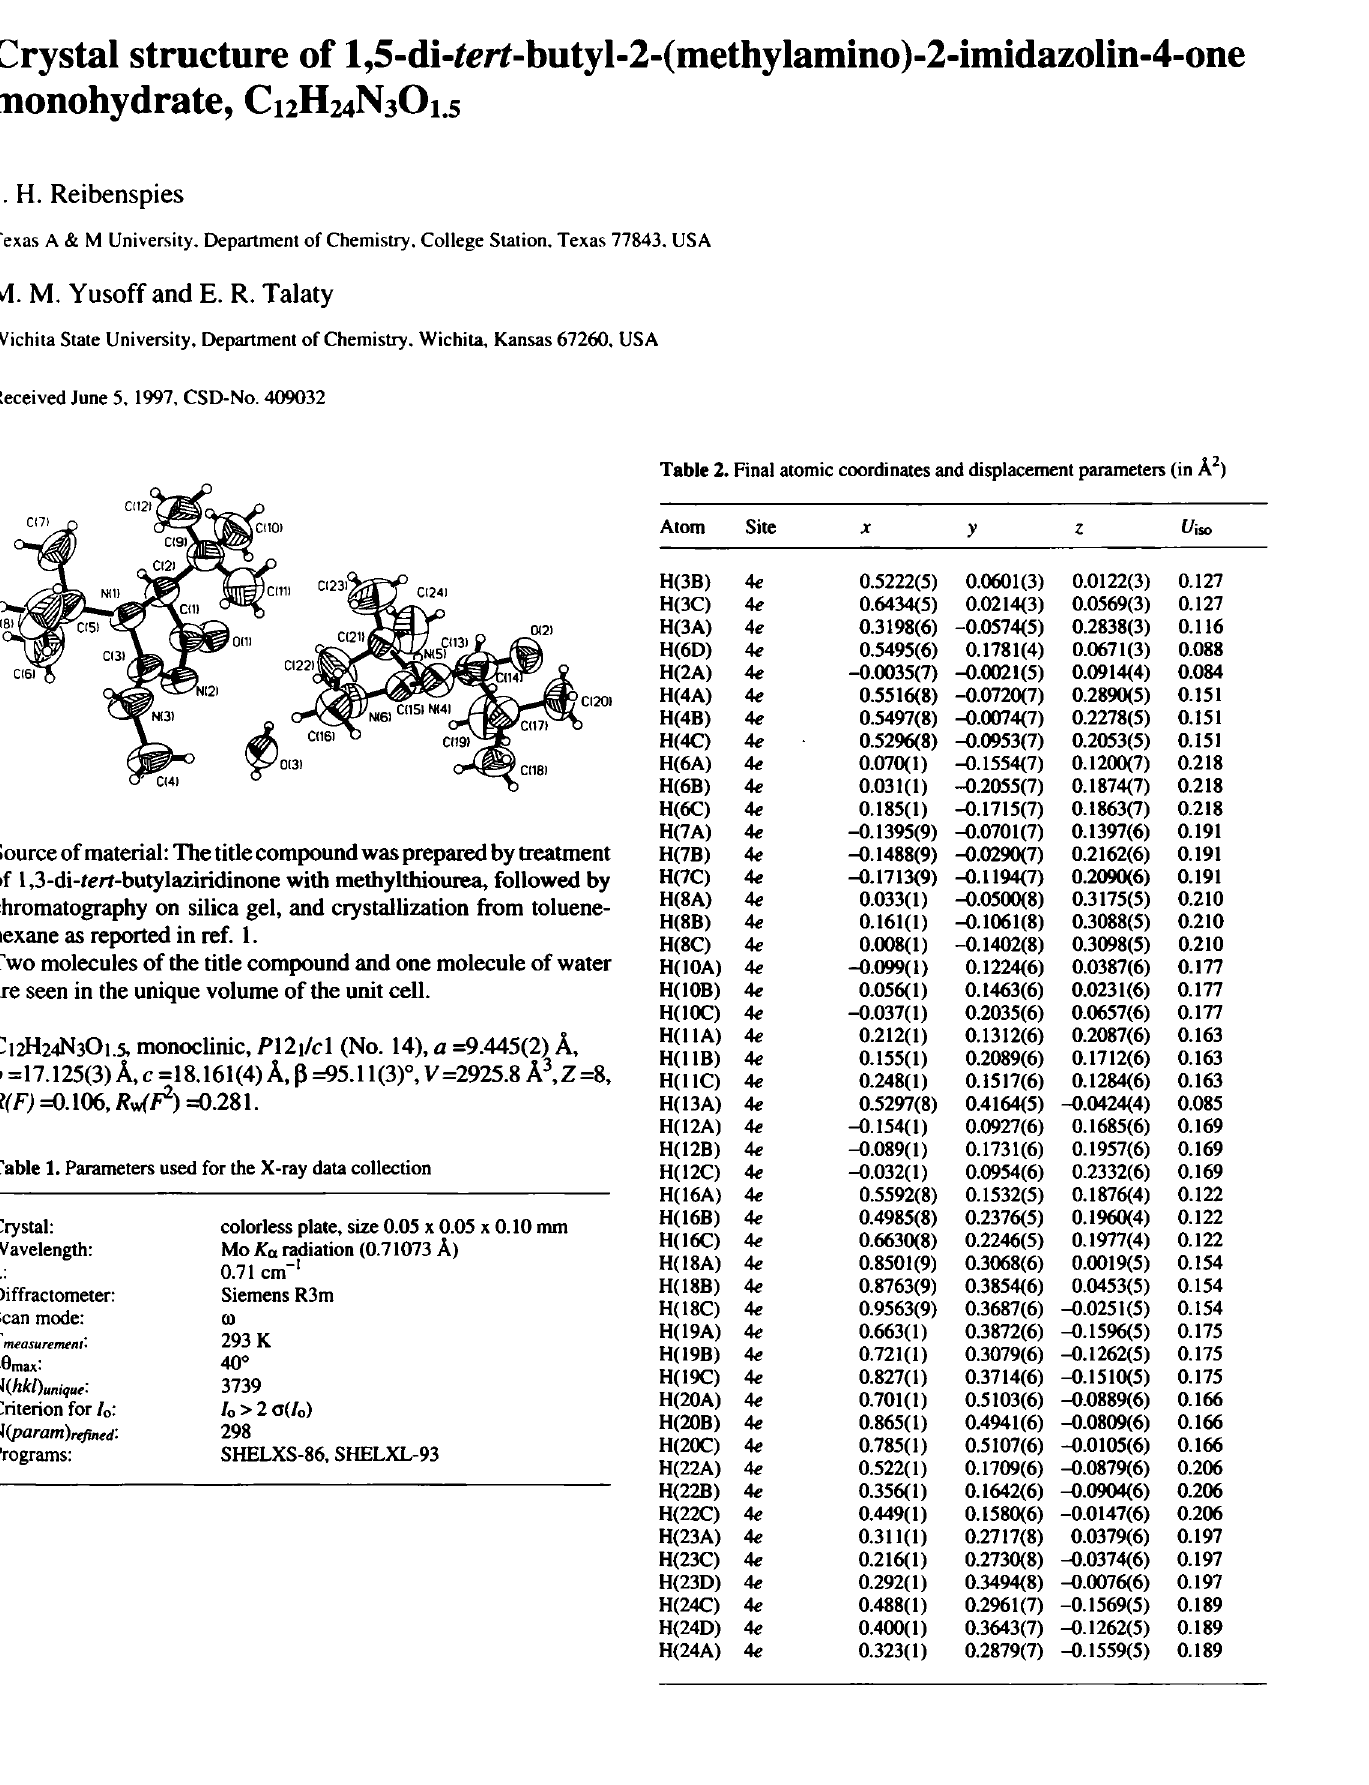
Table 1. Parameters used for the X-ray data